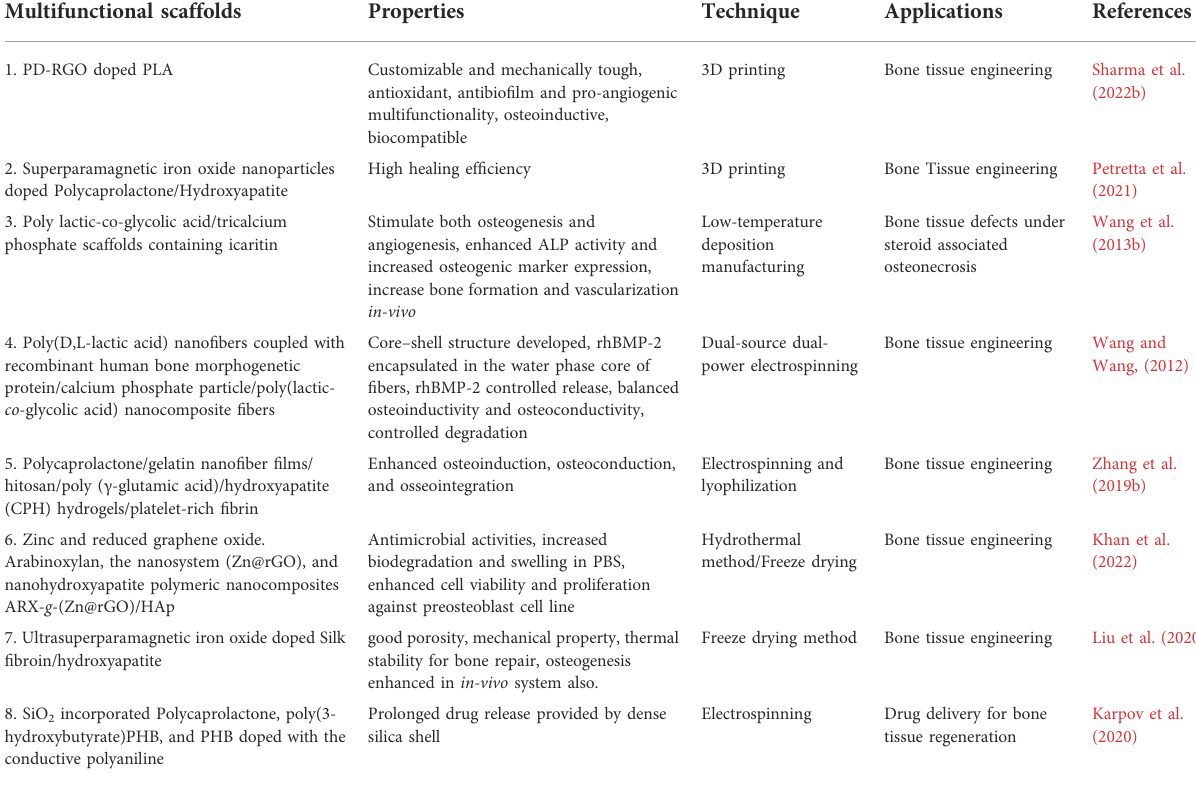
TABLE 6 Multifunctional polymeric scaffolds with their properties and